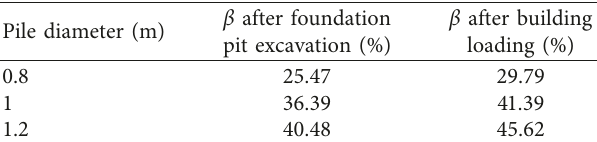
Figure 38: Decrement in maximum horizontal displacement of the tunnel structure under different isolation pile diameters. Table 12: Reinforcement effects of isolation piles on torsional deformation of the tunnel structure under different isolation pile diameters.